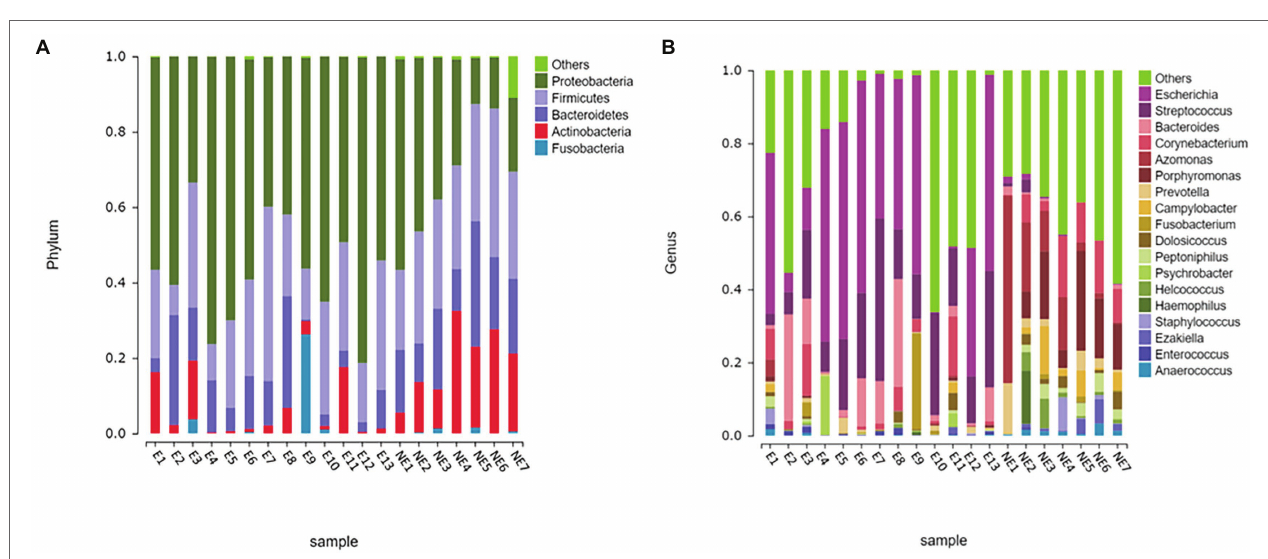
FIGURE 3 | Microbial community barplot. (A) Microbial community barplot at the phylum level. Bar charts showing the relative abundance of all genera detected in the vaginal secretions collected from the giant panda in the E (E1–E13) and the NE group (NE1–NE7). The identities of the microbiome were shown with color blocks on the right. (B) Microbial community barplot at the genus level. Bar charts showing the relative abundance of all genera detected in the vaginal secretions collected from the giant panda in the E (E1–E13) and the NE (NE1–NE7) group. The identities of the microbiome were shown with color blocks on the right.